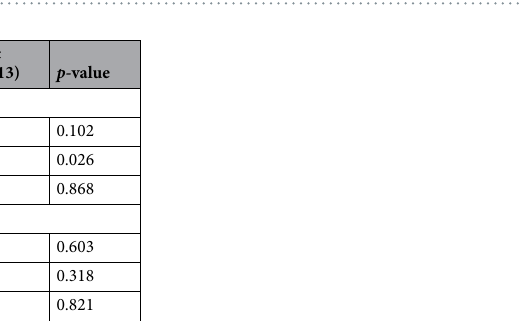
Table 1. Baseline characteristics of all patients according to stroke subtype. Apo, apolipoprotein; CAD, coronary artery disease; DM, diabetes mellitus; HDL-C, high-density lipoprotein cholesterol; hsCRP: high- sensitivity C-reactive protein; LDL-C, low-density lipoprotein cholesterol; TG, triglycerides; TC, total cholesterol. * Median values.